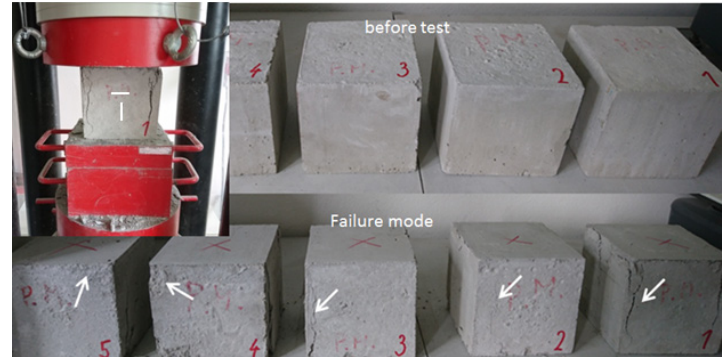
Figure 2. The concrete specimen in the testing machine with cracks appeared.